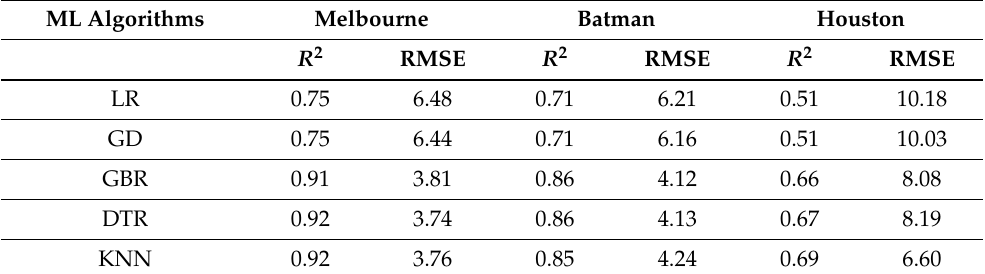
Table 2. R 2 and MSE [Mbps] Analysis of ML Algorithms for Melbourne, FL, Batman, Turkey, and Houston,